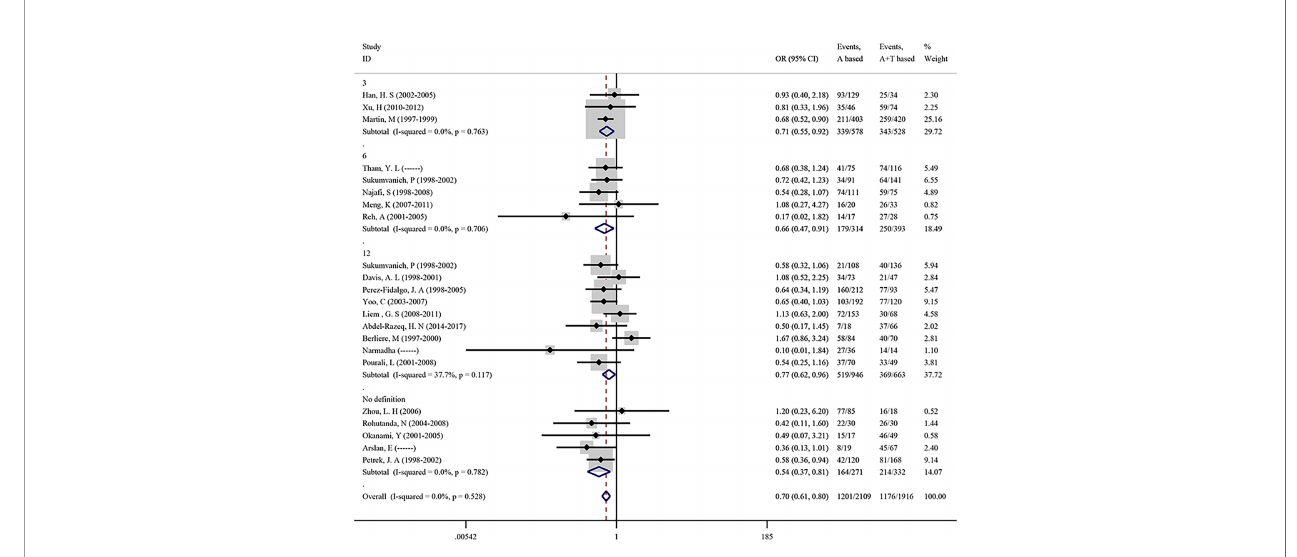
FIGURE 4 | Incidence of CIA based on the application of different chemotherapy